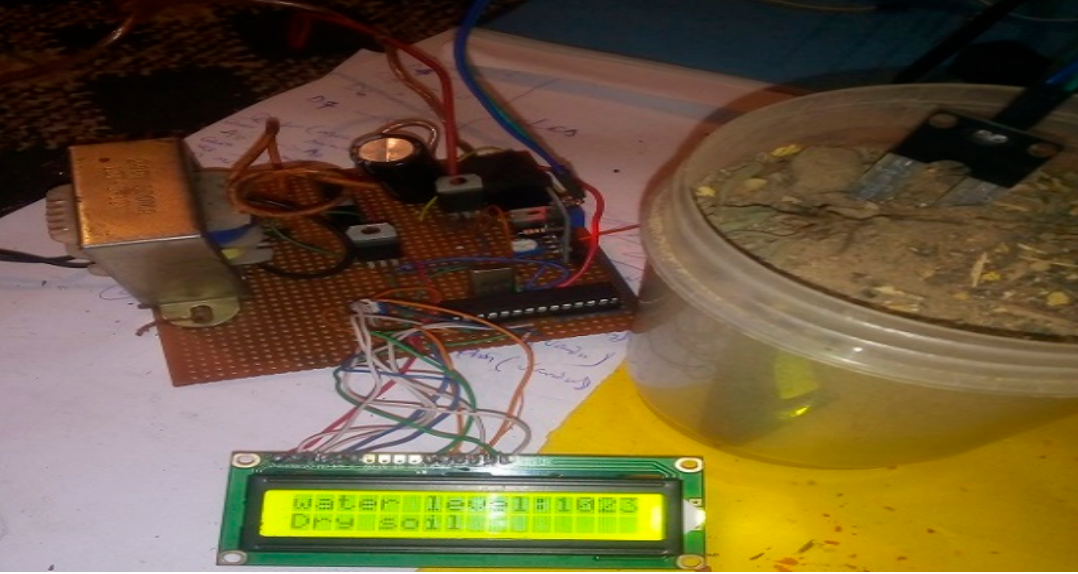
Figure 6. Low-cost sensor interface for Internet of Things (IoT)-based irrigation system component setup.